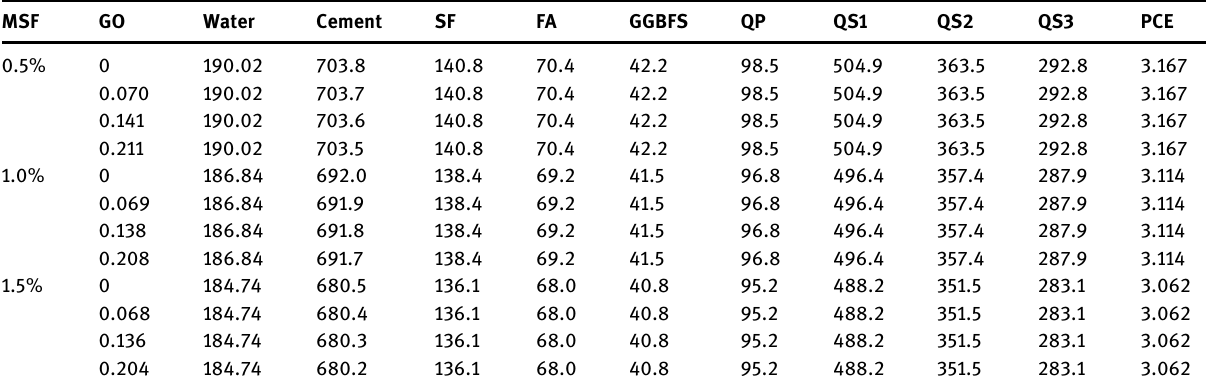
Table 2: Mix proportions of UHPC with high cement volume ( kg/m 3 )